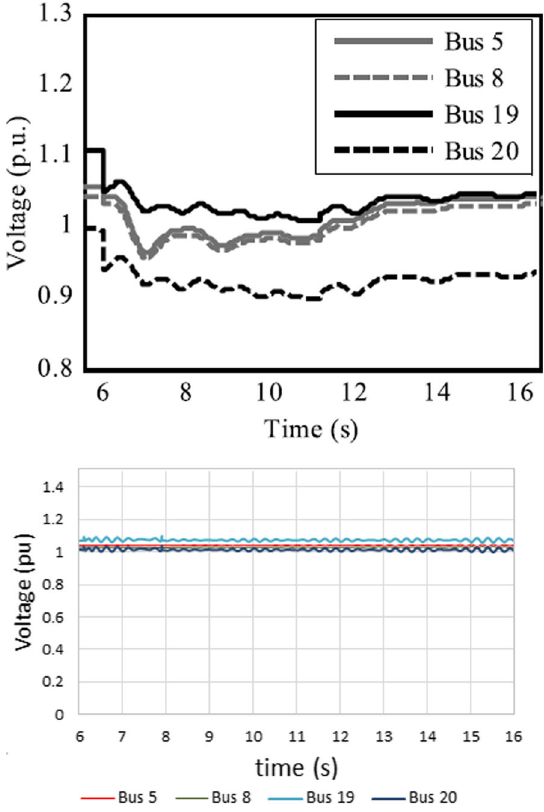
Fig. 22 VSRI(a) and VSI(b) based load